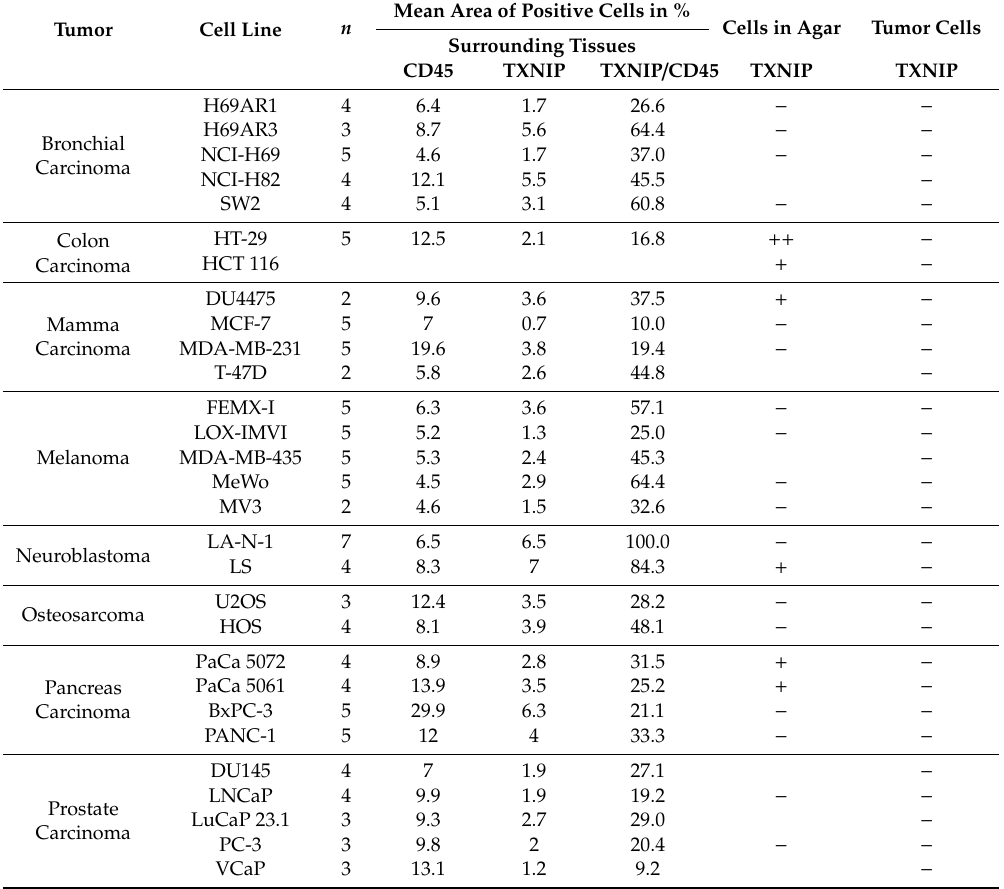
Table 2. Expression of thioredoxin interacting protein (TXNIP) in human cancer cell lines and mouse xenograft